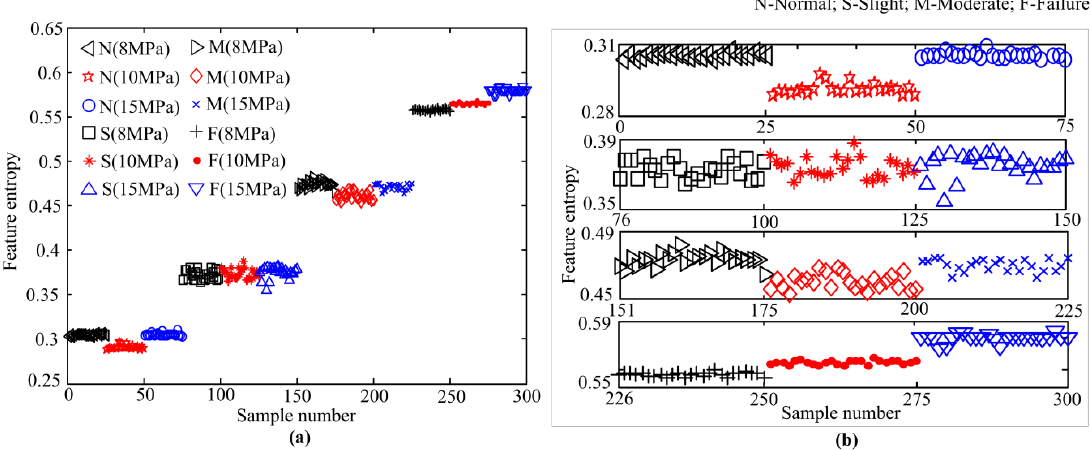
Figure 10. The feature entropy obtained from EMD2 for the different working conditions: ( a ) All samples and ( b ) partially enlarged drawings.